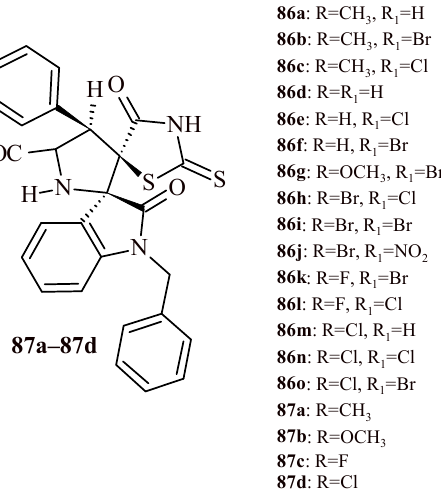
Figure 35. The 5-Arylidenethiazolidine-2,4-diones with α -amylase and α -glucosidase inhibitory ac- tivity.